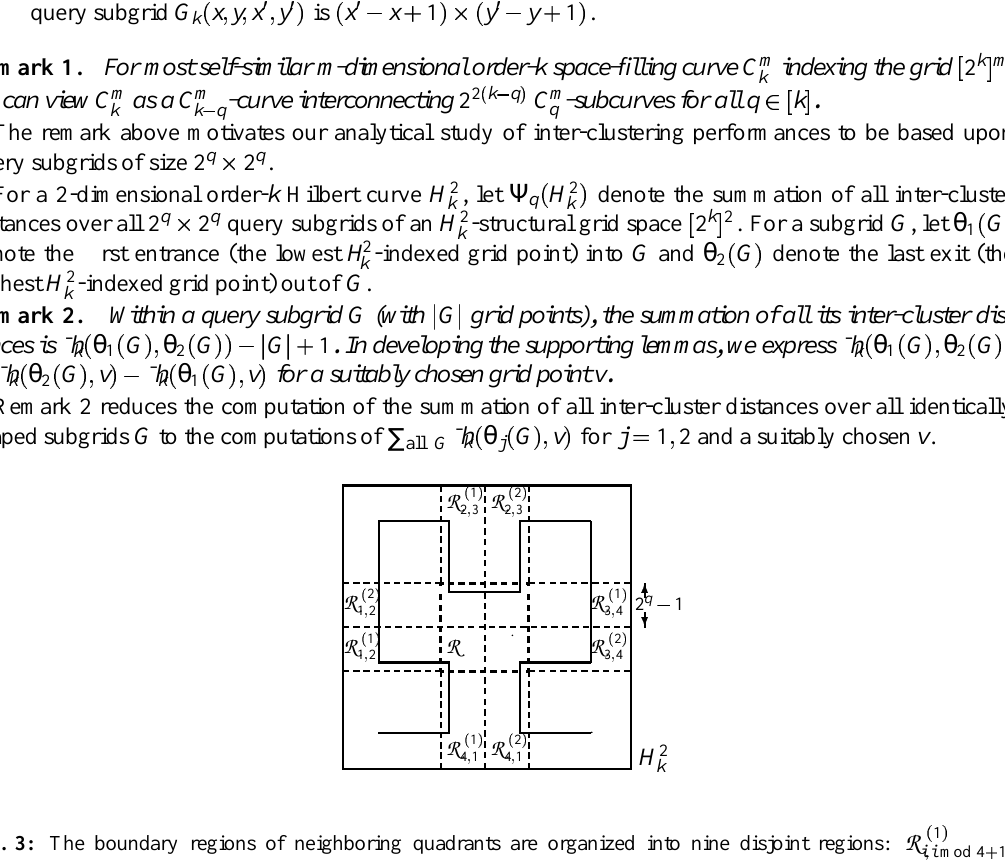
for i 1 2 3 4, and R (cid:5) (cid:17) (cid:17) (cid:17)